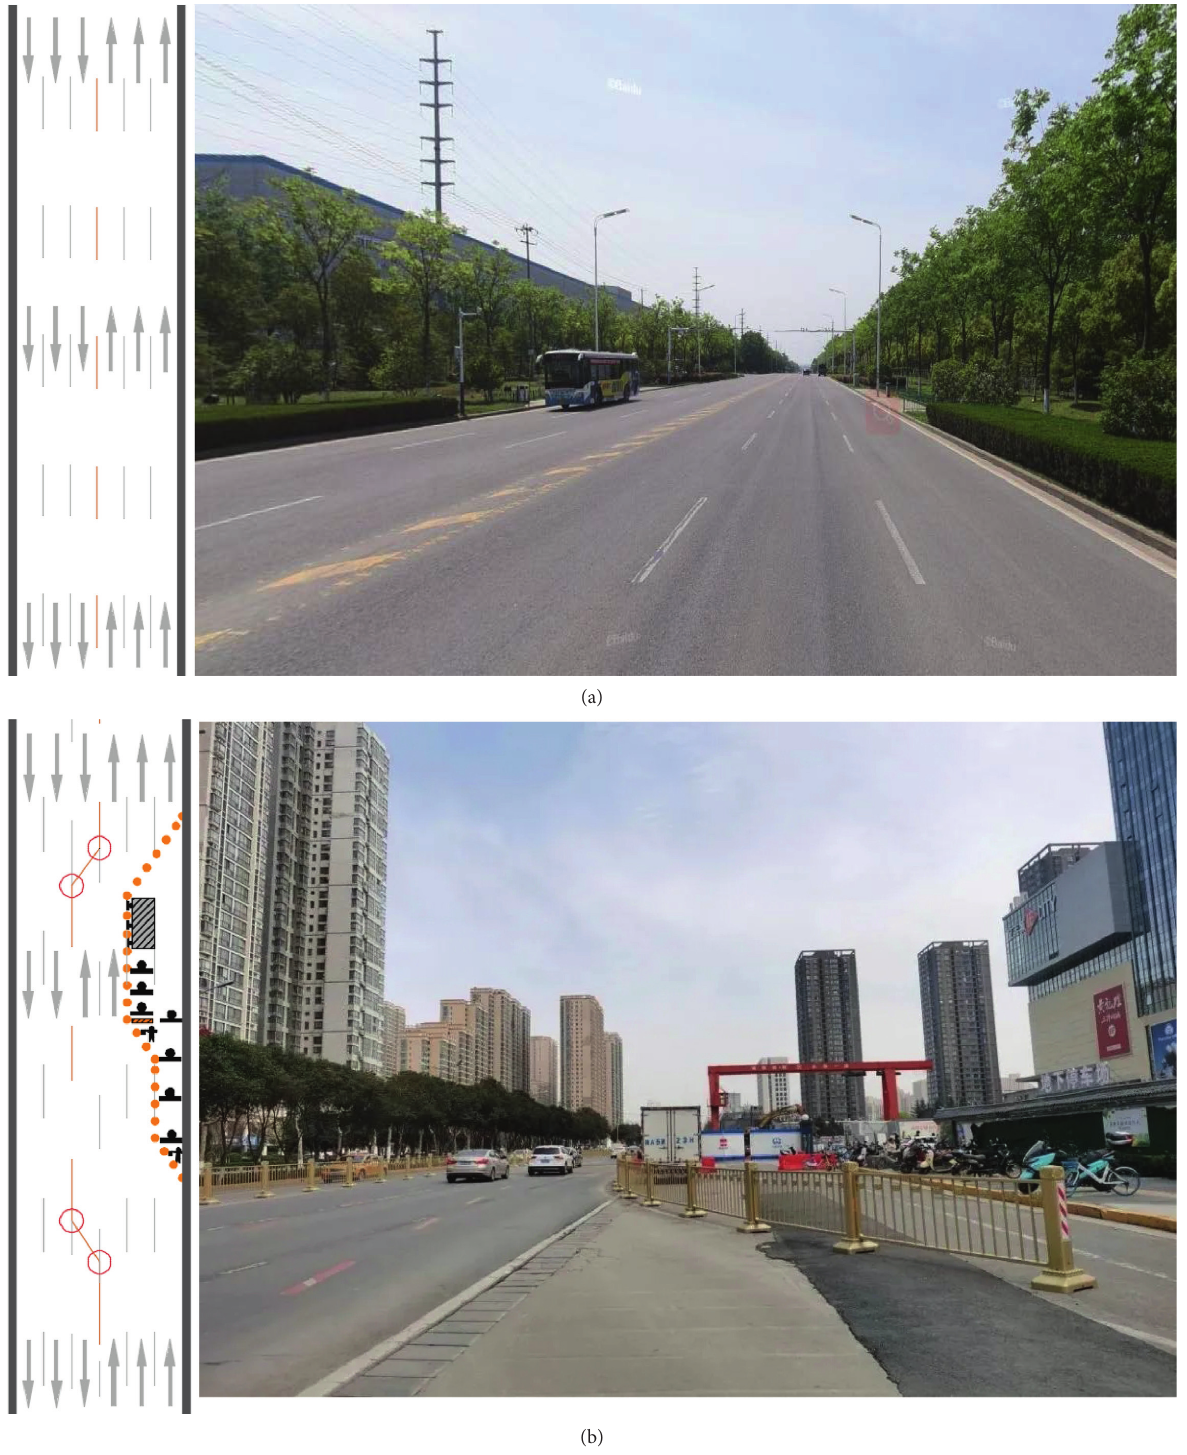
Figure 1: Rail transit construction and work zone; (a) road segment before rail transit construction; (b) road condition under rail transit